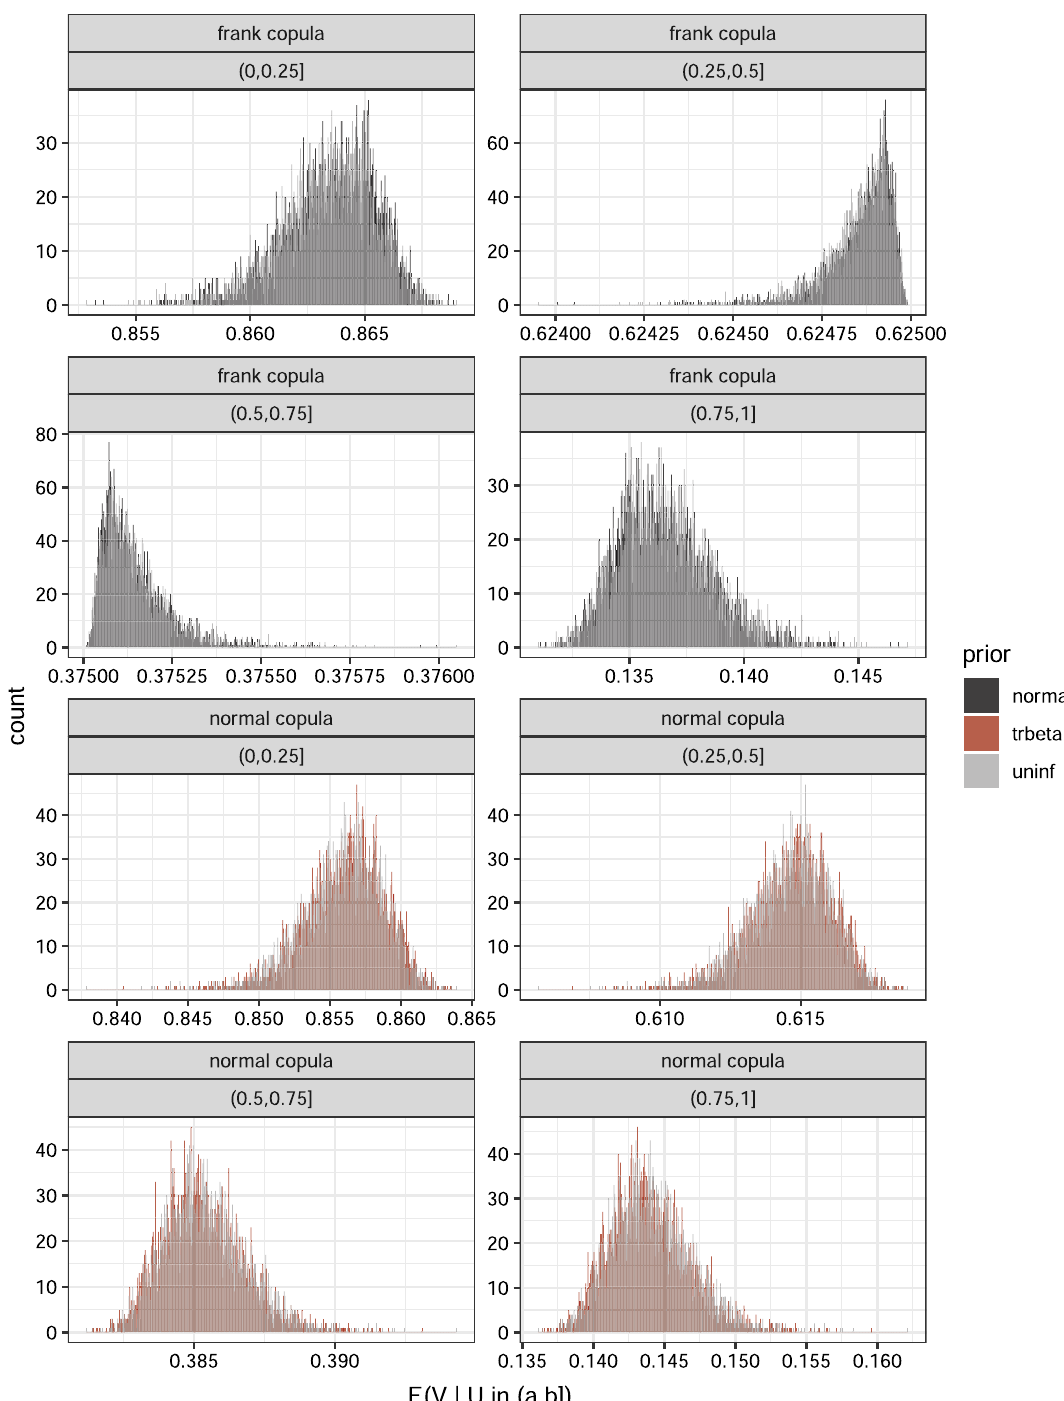
Figure 5. Conditional expectation, from equations (11) and (12) with h (and q ) simulated from the posterior distributions (non- informative and informative